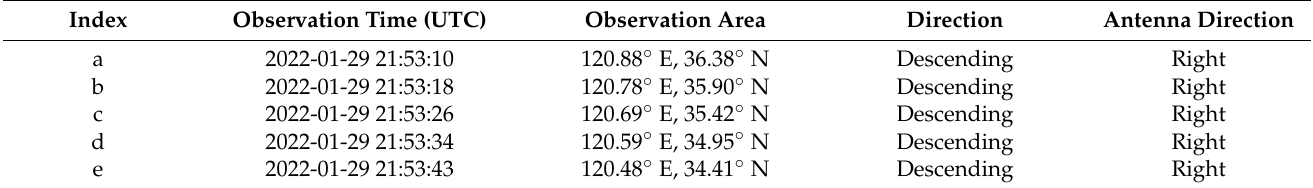
Table 1. GF − 3 satellite data obtained from the experiment conducted in Qing